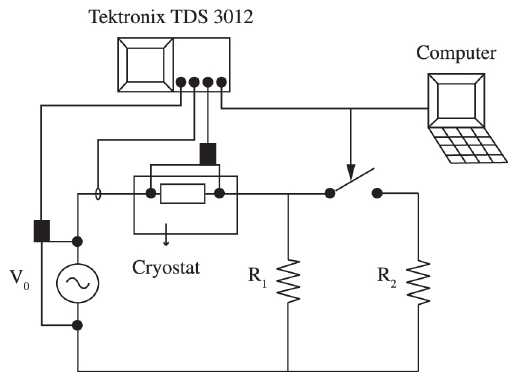
Figure 1. Experimental setup used for SFCL test. Superconducting pellet is placed into cryostat in series with load